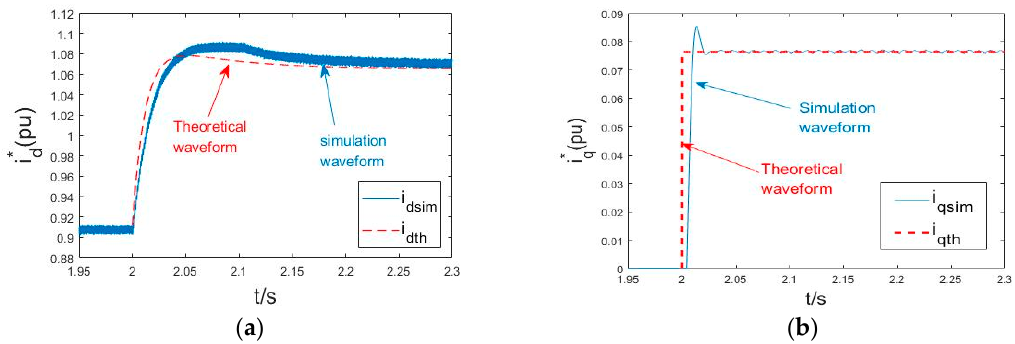
Figure 8. ( a ) Waveforms of bus voltage fault component. ( b ) Waveforms of phase-A output current.